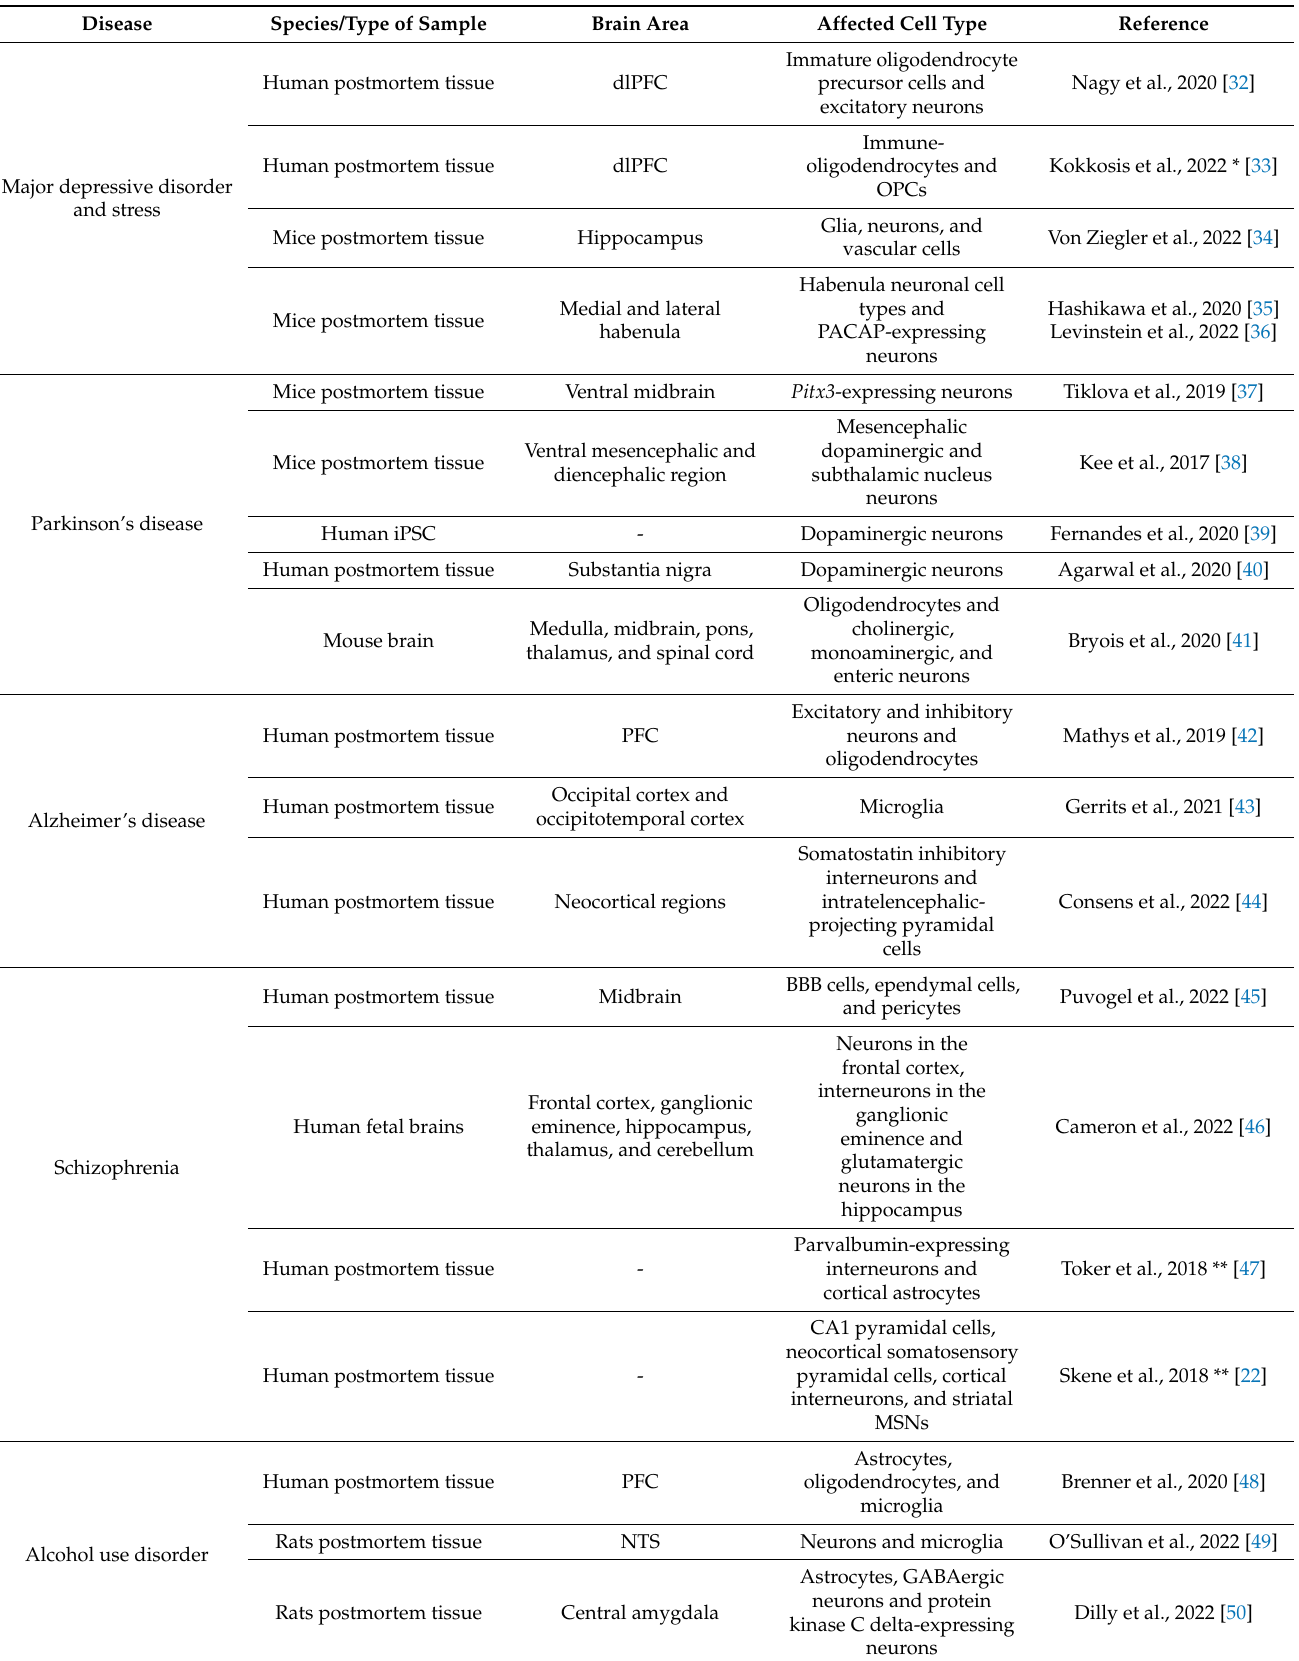
Table 1. Single-cell or single-nuclei RNA-seq studies of psychiatric